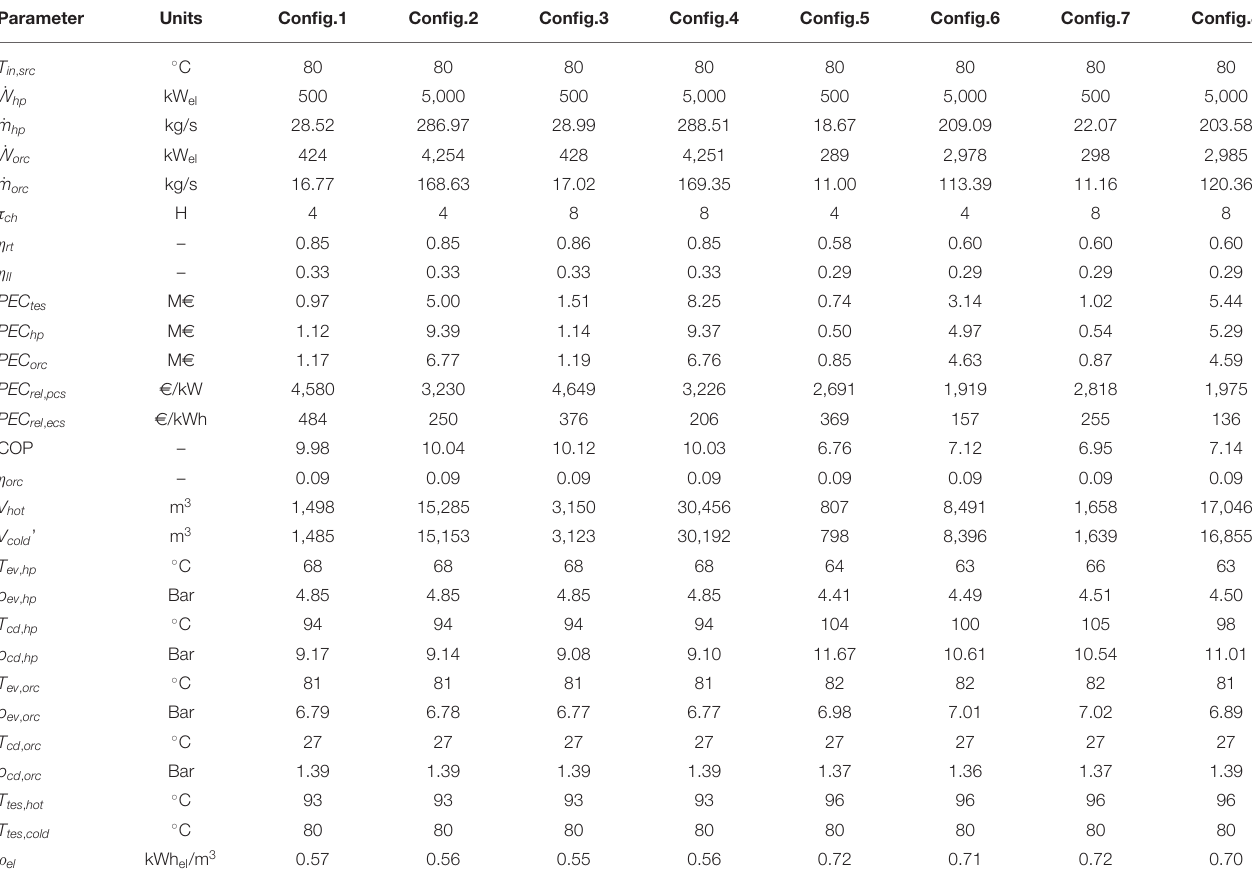
TABLE 8 | TI-PTES exemplificative